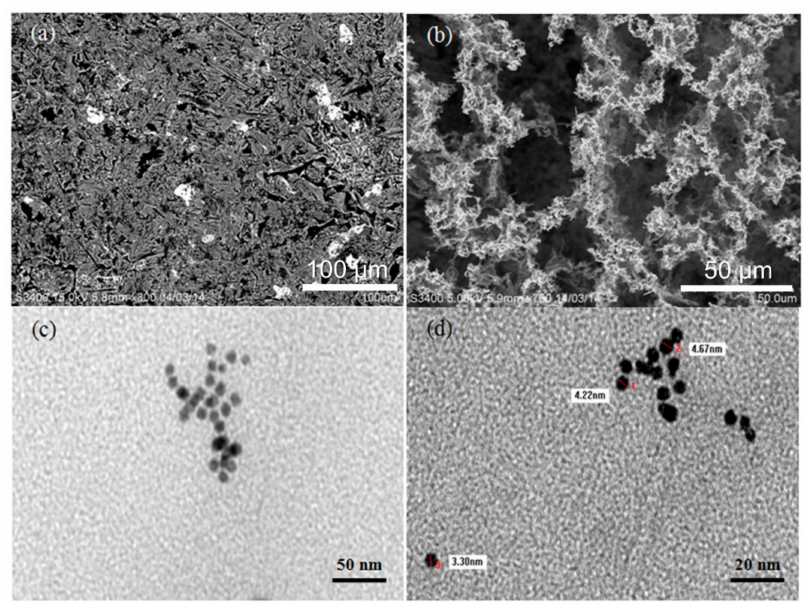
Figure 1. SEM of AuNPs ( a ), AuNPs/melamine ( b ), and TEM of AuNPs ( c , d ).